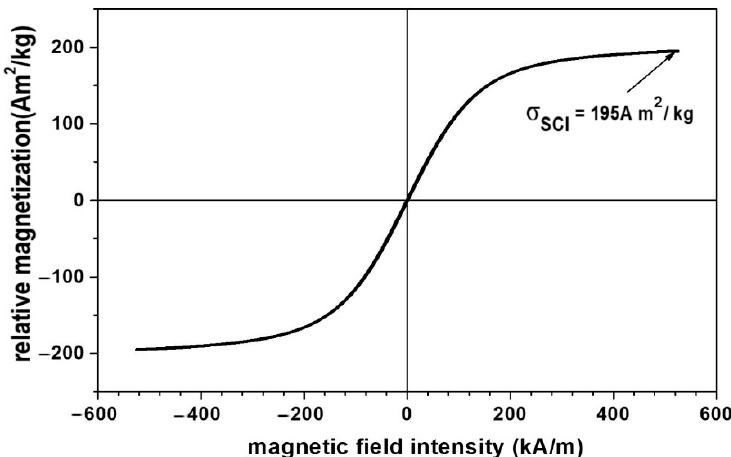
Figure 2. Magnetization slope for the CI microparticles. Figure 2 shows a linear dependence of the relative magnetization of the CI microparticles with the intensity of the magnetic field. For magnetic field intensities of H ≥ 540 kA/m, the relative saturation magnetization of the CI microparticles is σ SCI = 195 Am 2 /kg.